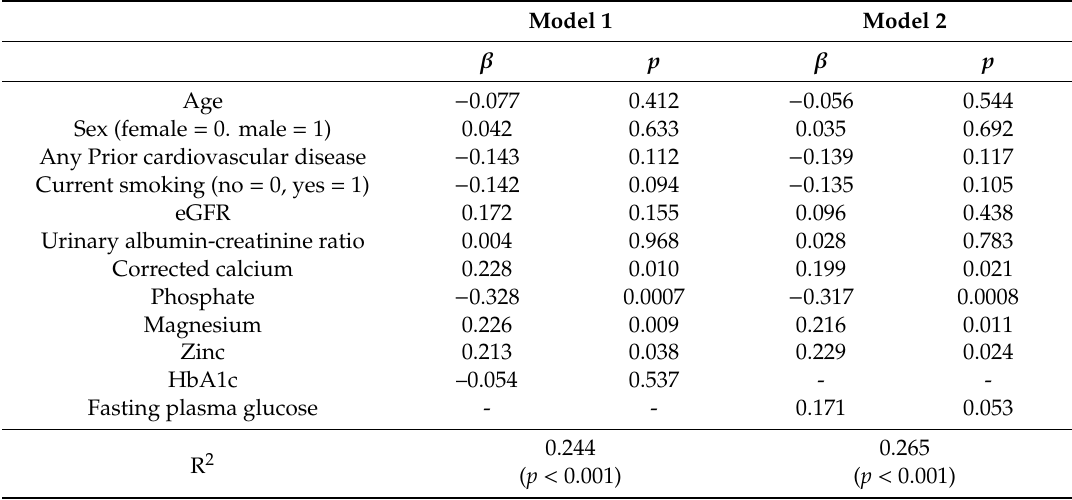
Table 3. Factors associated with serum calcification propensity (T 50 ) in 132 type 2 diabetes patients.